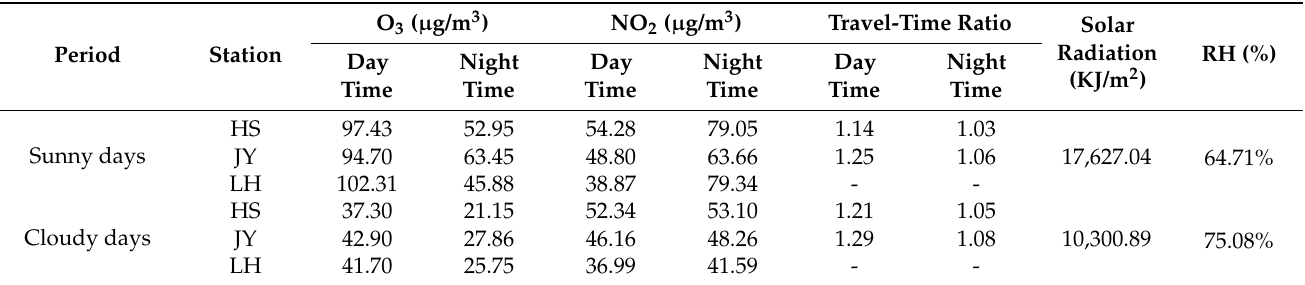
Table 3. The pollutant concentrations and related parameters in the two periods.